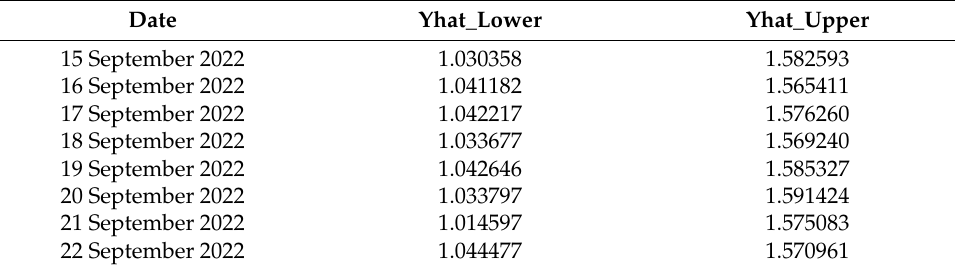
Figure 15. Error histograms of the LSTM model in predicting the prices of the XRP cryptocurrency in ( a ) training and ( b ) testing. Table 10. Results of the XRP data set for the last 15